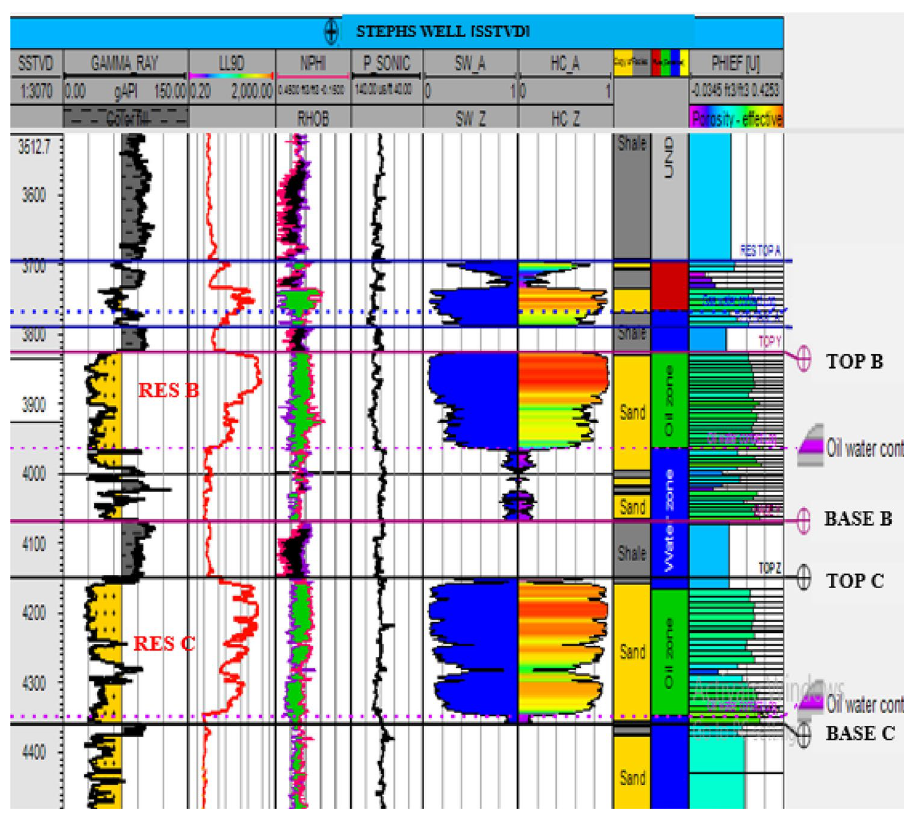
Fig. 5 Well section showing the reservoir units